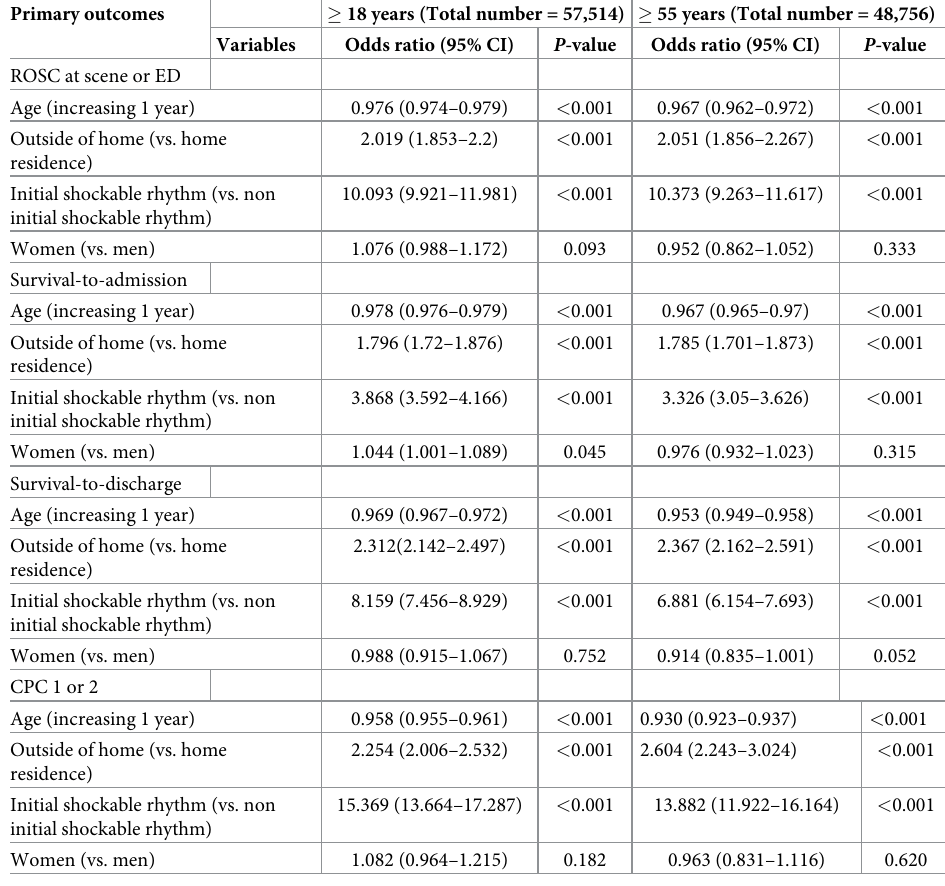
Table 5. Adjusted logistic model with propensity score matching